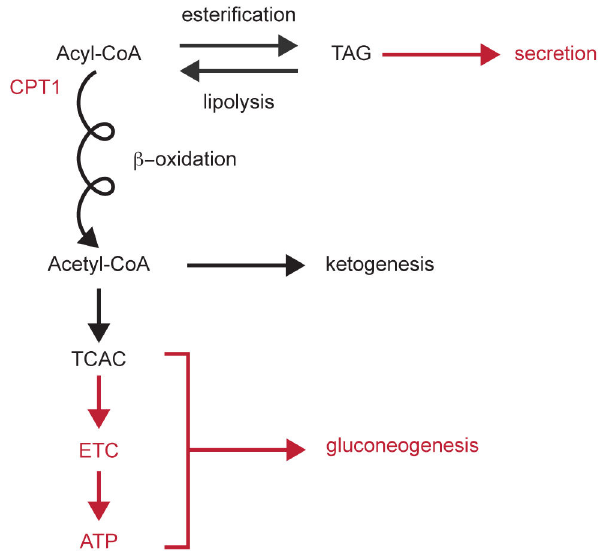
Figure 9. Influence of choline restriction in integrated hepatic mitochondrial fatty acyl-CoA metabolism. Red text and red arrows highlight hepatic processes known to be impaired by administration of experimental choline deficient diets. Unlike previous observations using lower fat choline deficient versus replete formulations, in this study, choline repletion in ~90% kcal fat diets did not alter triacylglycerol (TAG) secretion as VLDL. However, choline restriction in a ~90% kcal fat diet was associated with mitochondrial structural and functional abnormalities, which were linked to liver fat accumulation and injury. CPT1, carnitine palmitoyltransferase 1; TCAC, tricarboxylic acid cycle; ETC, electron transport chain; ATP, adenosine